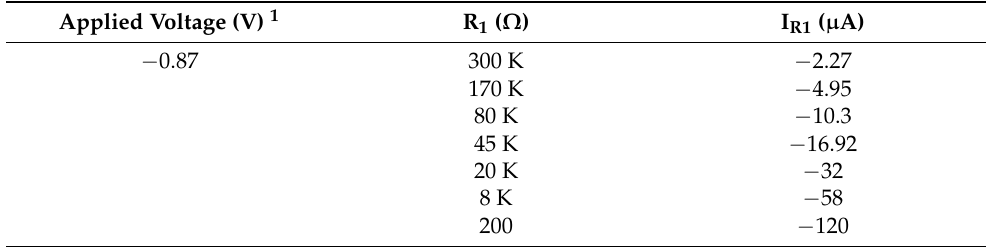
Table 1. Simulation results for applied voltage of − 0.87 V assuming R 2 = 305 Ω , R 4 = 6.50 k Ω .